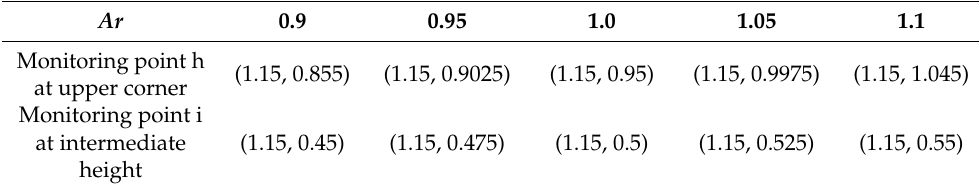
Table 4. Layout of monitoring points in liquid bridge under different aspect ratios.